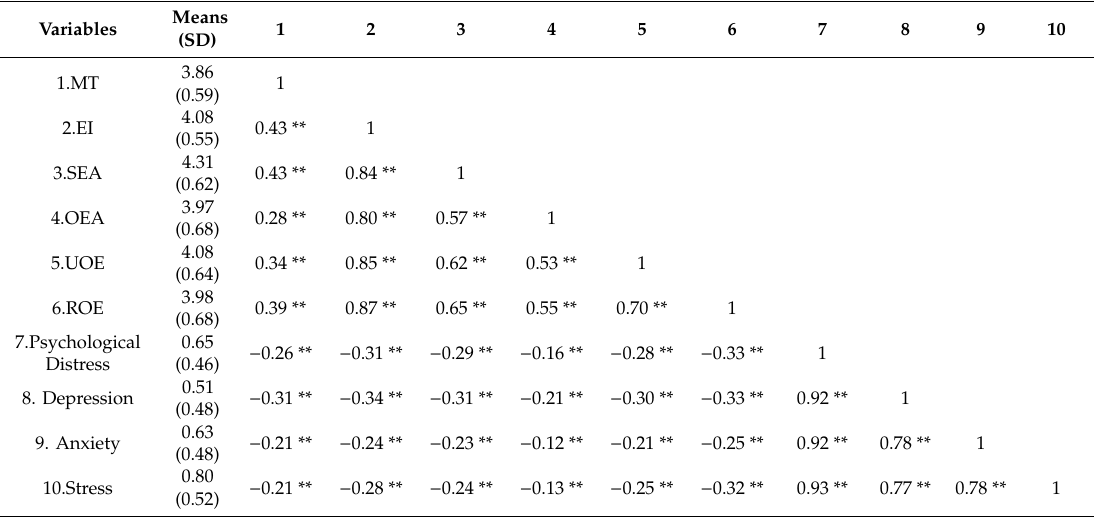
Table 1. The means, standard deviations and inter-correlations of all the studied variables. Variables